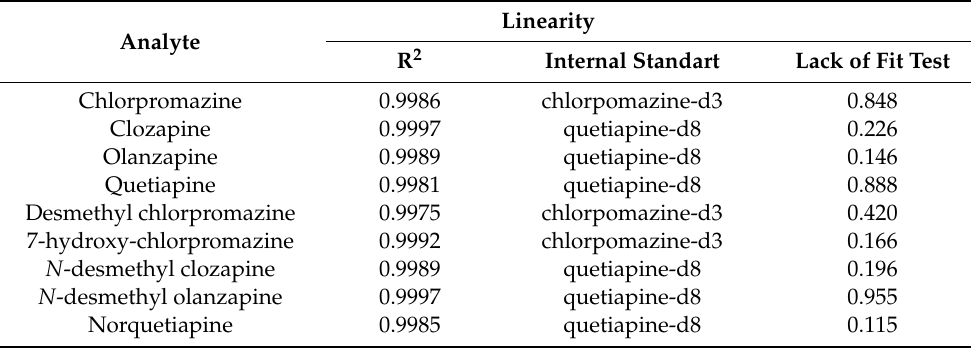
Table 3. Linearity of the SPME-UHPLC-MS/MS method.